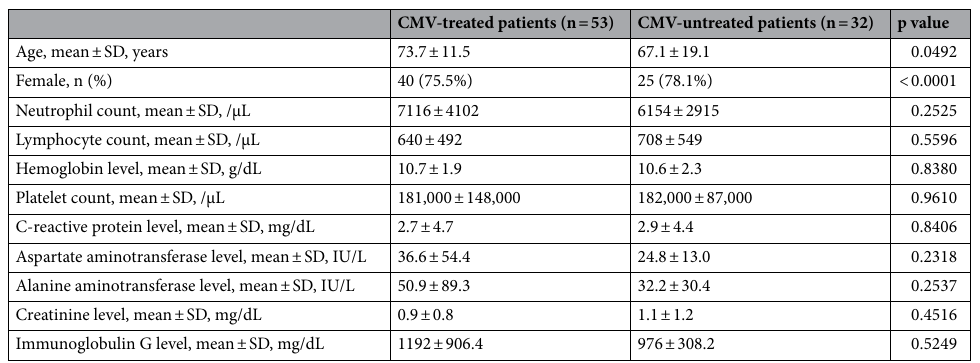
Table 5. Characteristics of CMV-treated and CMV-untreated